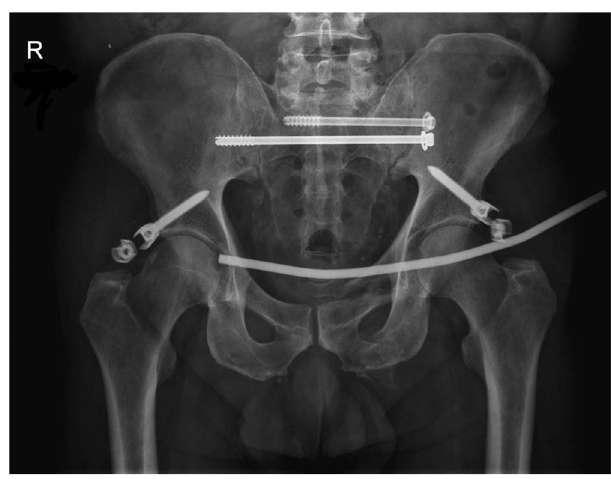
Figure 4. Metalware failure: device locking mechanism